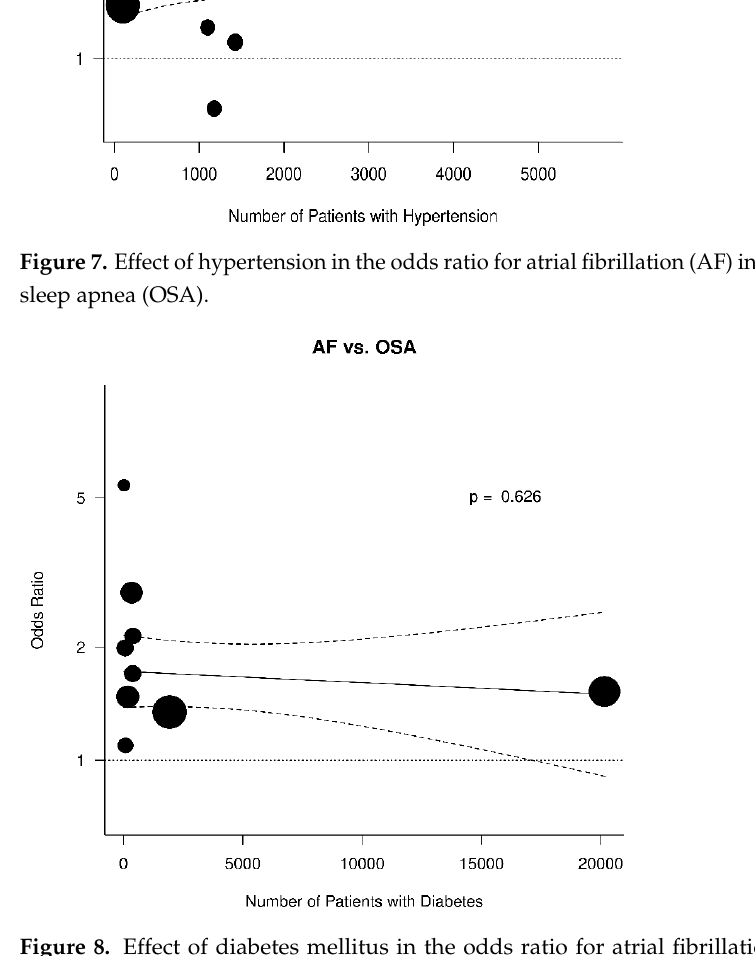
Figure 8. Effect of diabetes mellitus in the odds ratio for atrial fibrillation (AF) in patients with obstructive sleep apnea (OSA).